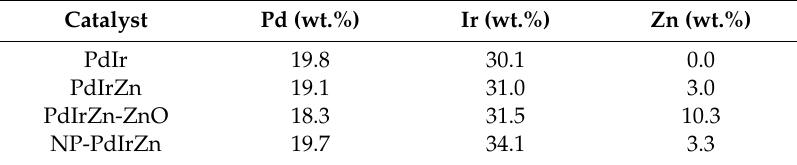
Table 1. ICP analyses of PdIr, PdIrZn, PdIrZn-ZnO, and NP-PdIrZn catalyst. Catalyst Pd